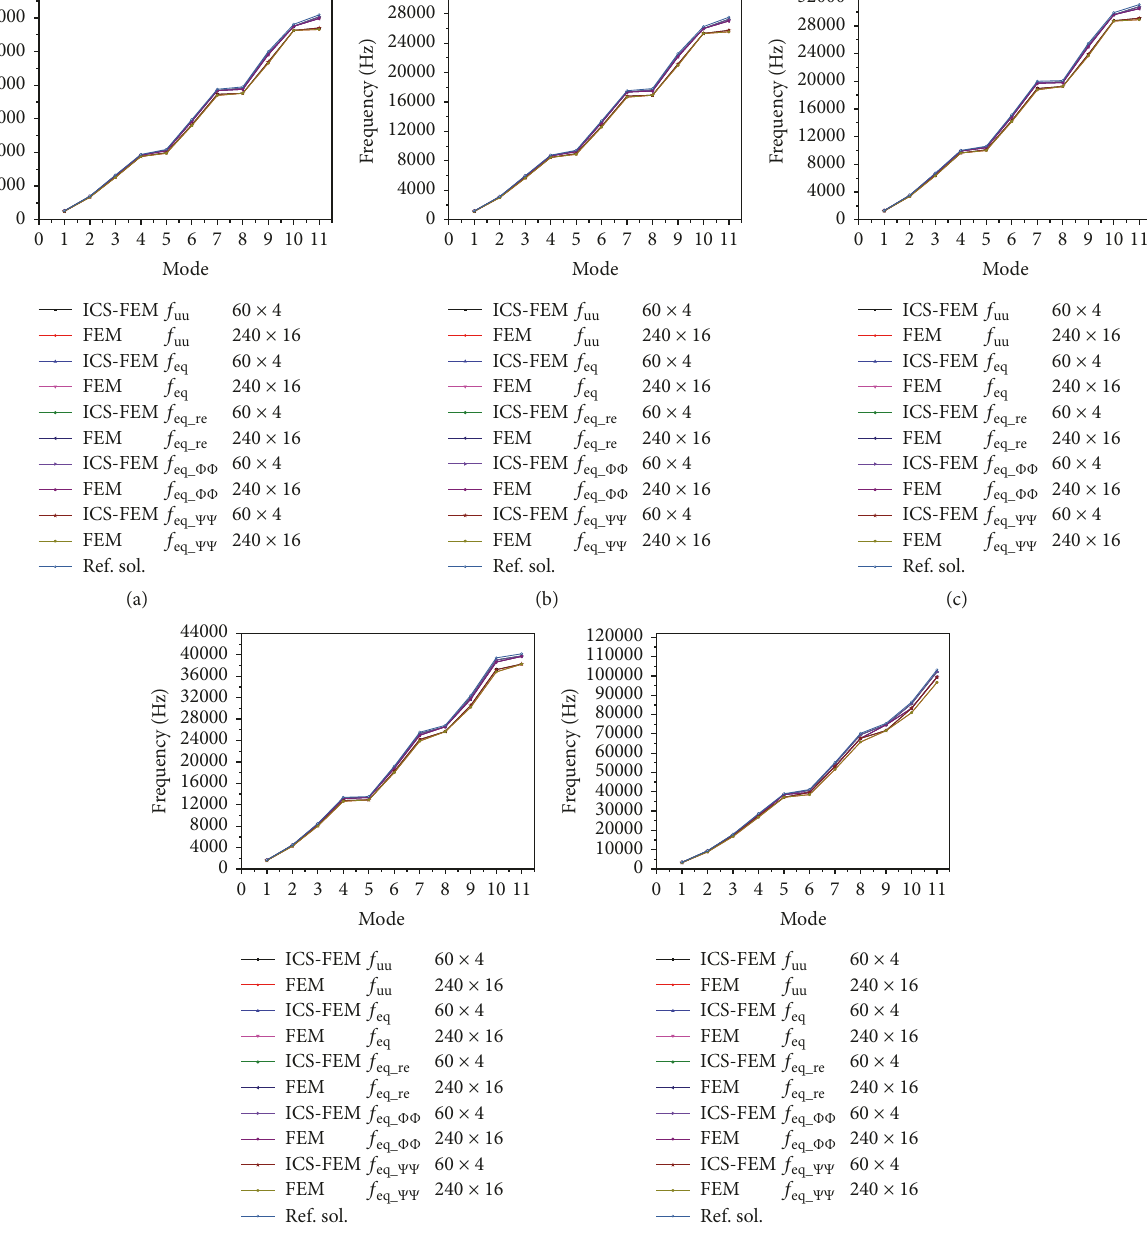
point were adopted directly. ICS-FEM avoided the deriva- tive of the shape functions but only transformed the area integral to the boundary integral in the solution domain, which omitted the requirement of continuity of the shape